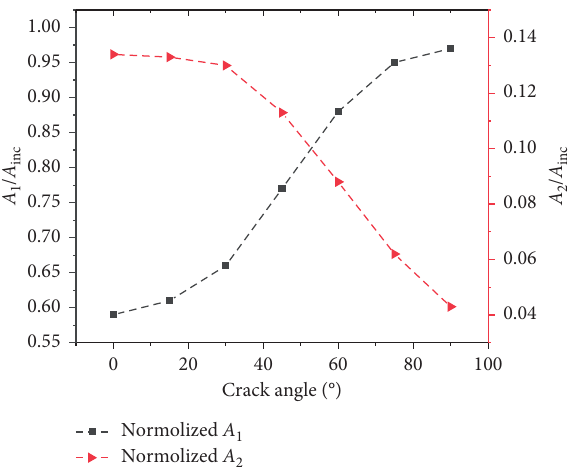
Figure 9: Distribution of fundamental A for various crack angles 1 versus second harmonic